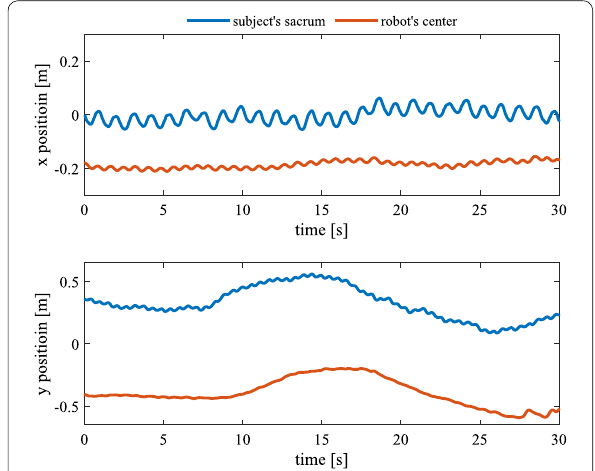
Fig. 7 Trajectories of the user’s sacrum position and the robot’s center position. The plots show the position of the user’s sacrum and the robot in the user companion test. The user moves forward and backward, and the robot follows the user’s